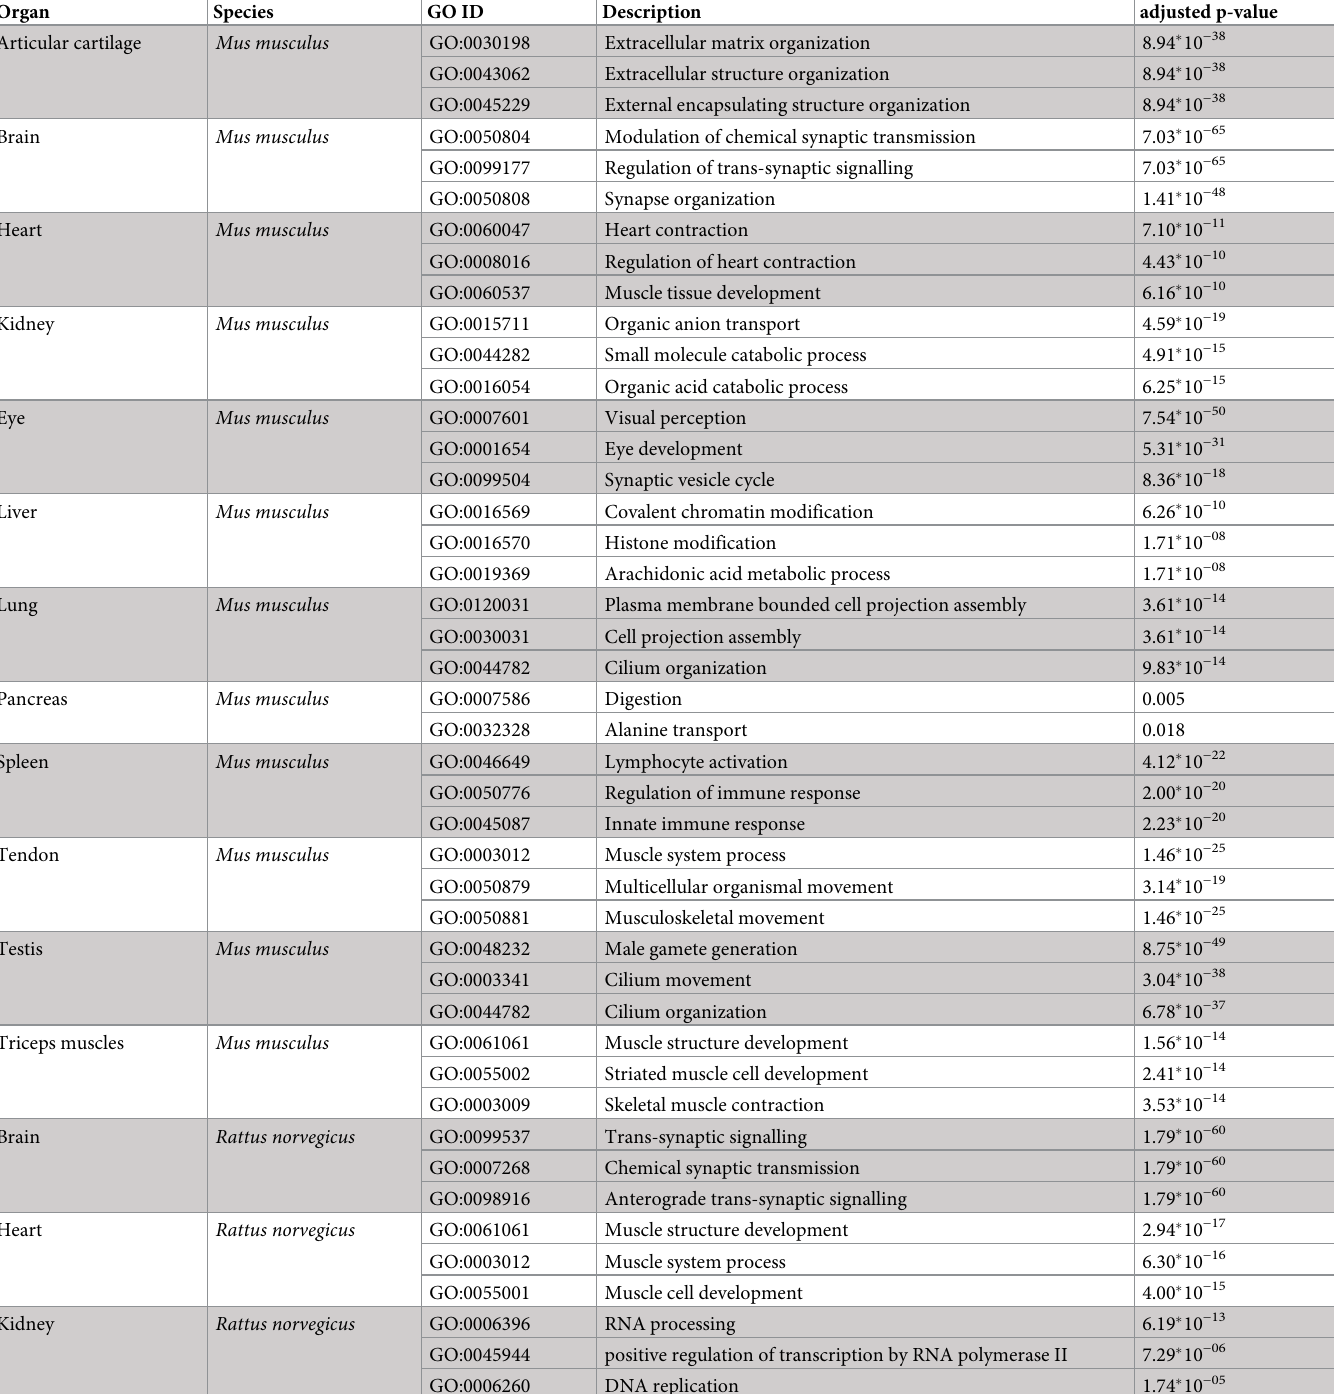
Table 2. Analysis of the top three GO terms for each organ in mouse and rat using the elevated organ-specific and group-specific canonical proteins as described in the ‘Methods’ section. Organ